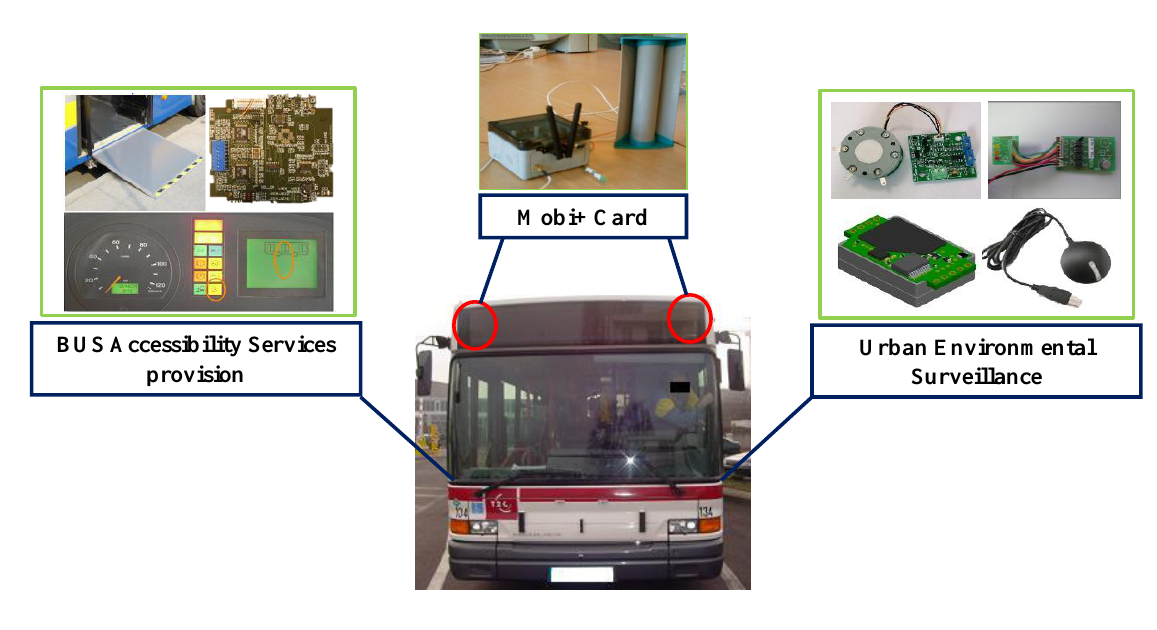
Figure 6. BUS subsystem of Mobi+.